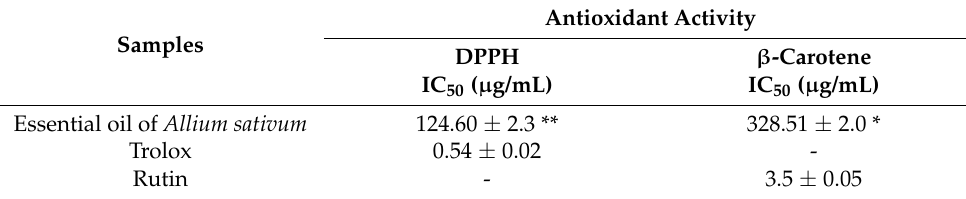
Table 2. Antioxidant activities of the A. sativum essential oil.